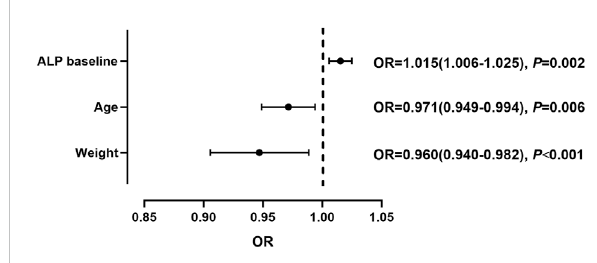
FIGURE 4 Independent risk factors for tacrolimus-induced liver